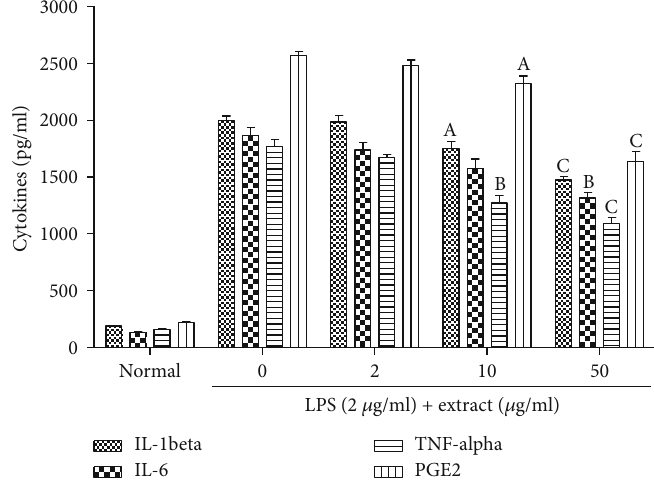
Figure 1: E ff ect of methanolic extract of D. benthamianus on proin fl ammatory cytokine production stimulated by LPS (lipopolysaccharides). Each value represents the mean ± SEM ; a p < 0 : 05 , b p < 0 : 01 , and c p < 0 : 001 : signi fi cant di ff erence compared to the normal group. The percentage values were obtained using various concentrations of test compounds, and readings are presented as mean of triplicates. IL: interleukin; TNF: tumor necrosis factor; PGE2: prostaglandin E2. Table 3: E ff ect of methanolic extract of D. benthamianus stem bark on ethanol-induced gastric lesions in rats. Treatment